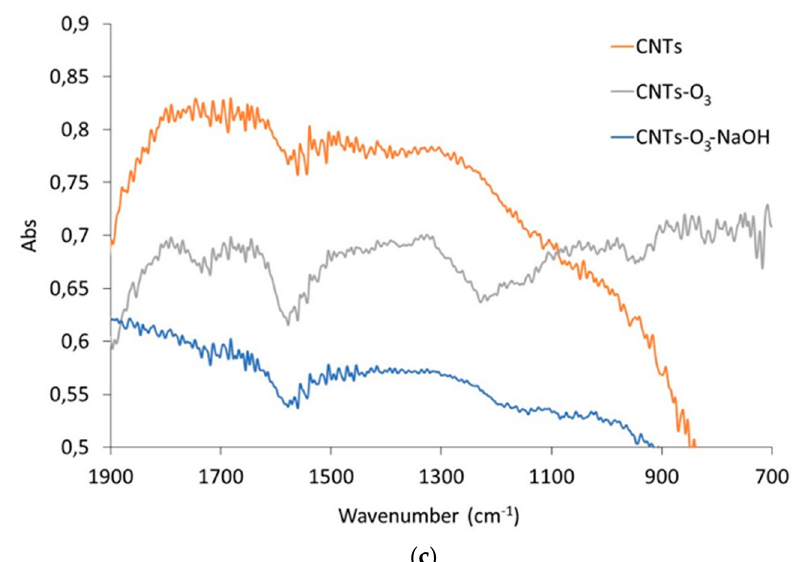
Figure 2. IR spectra of ( a ) original CNTs and CNTs treated with HNO 3 -H 2 SO 4 ; ( b ) CNTs treated with O 3 for different times and temperature and ( c ) CNTs treated with O 3 -NaOH.